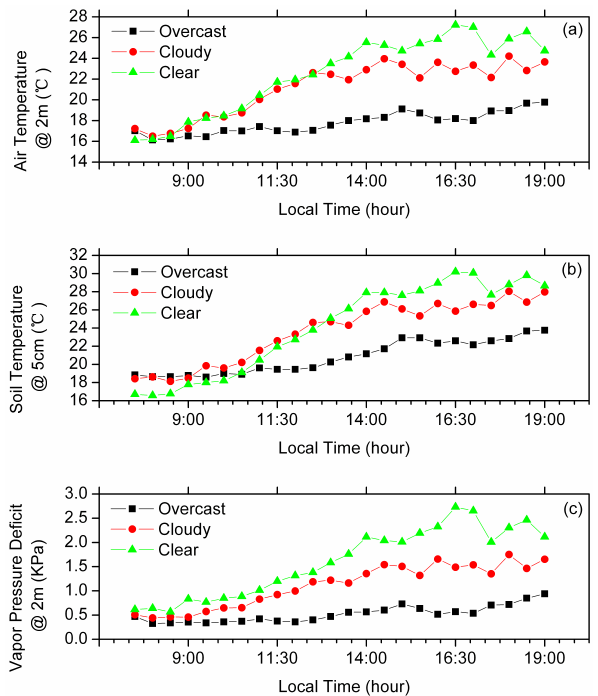
Fig. 8. Comparison of averaged air temperature, soil temperature and vapor pressure deficit under three sky conditions (i.e., clear (non-cloudy), cloudy (0.6 < cloudiness < 1) and overcast (cloudi- ness=1)) from 07:00 to